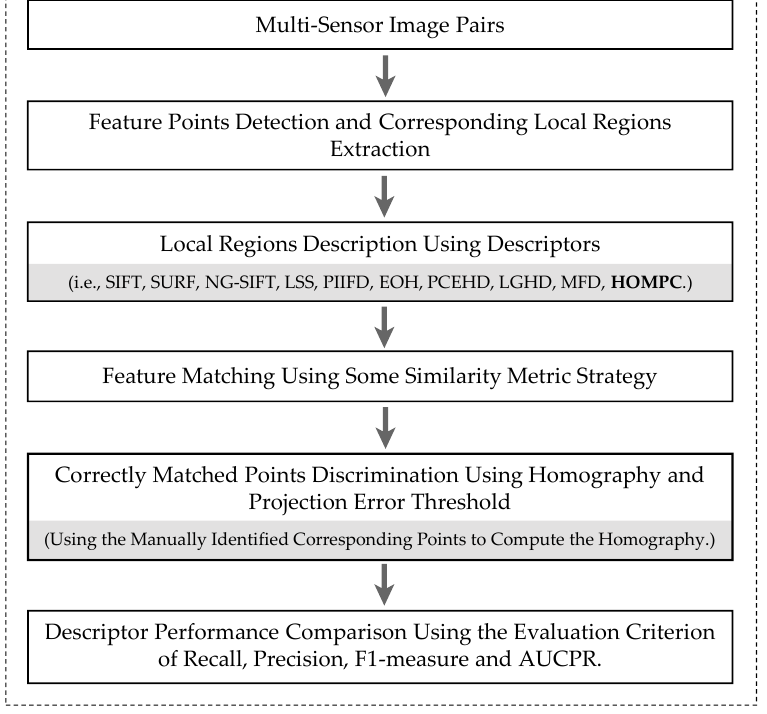
Figure 7. The flowchart to evaluate the descriptor performance in our experiments.